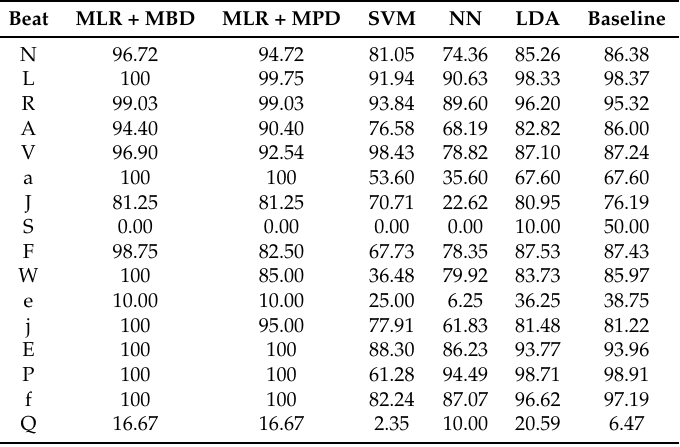
Table 5. Method performance for each beat class on